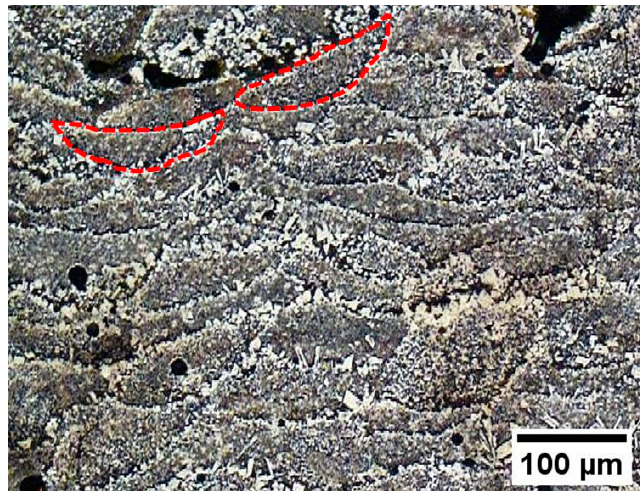
Figure 5. Micrograph of a sample cross section revealing the molten pool shape.